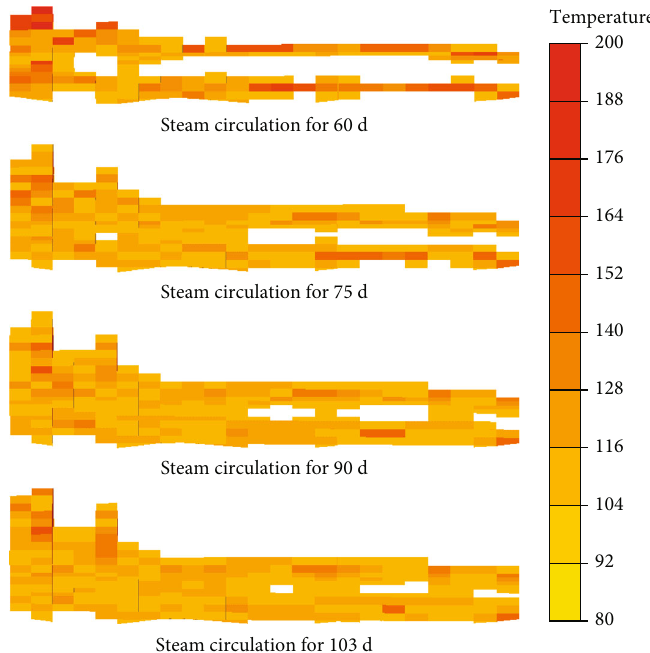
Figure 10: Preheating temperature fi eld obtained by tracking numerical